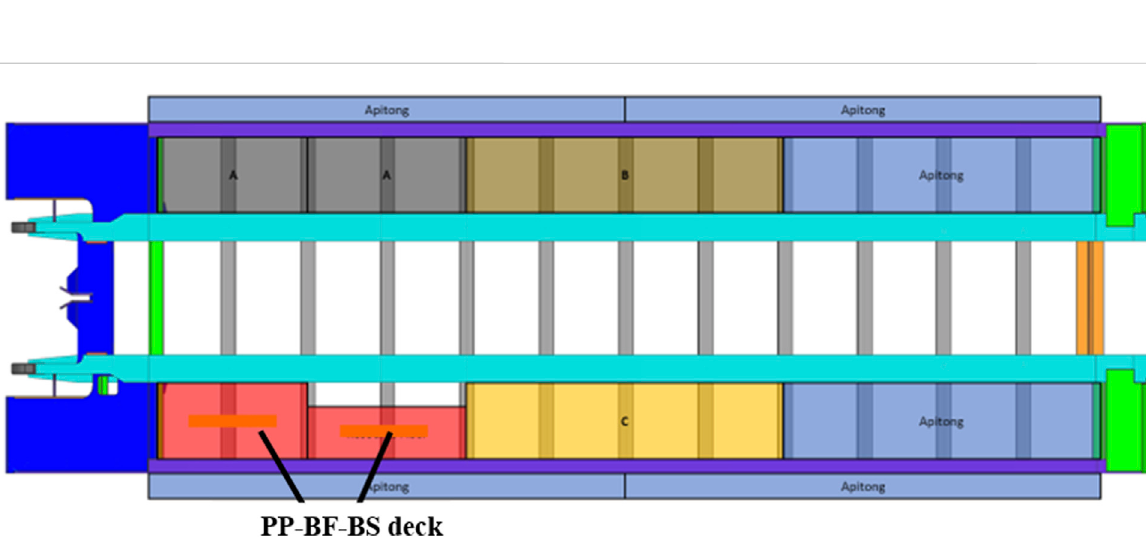
FIGURE 12 Arrangement of planks on the trailer frame. PP-BF-BS deck panels are marked in the fi gure. The other panels were made of other elements not discussed in this